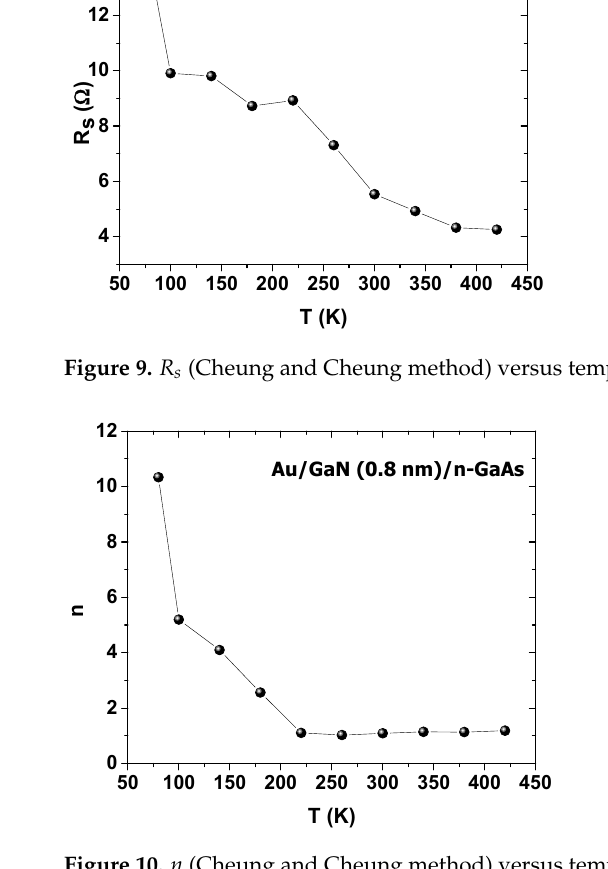
Figure 10. n (Cheung and Cheung method) versus temperature.